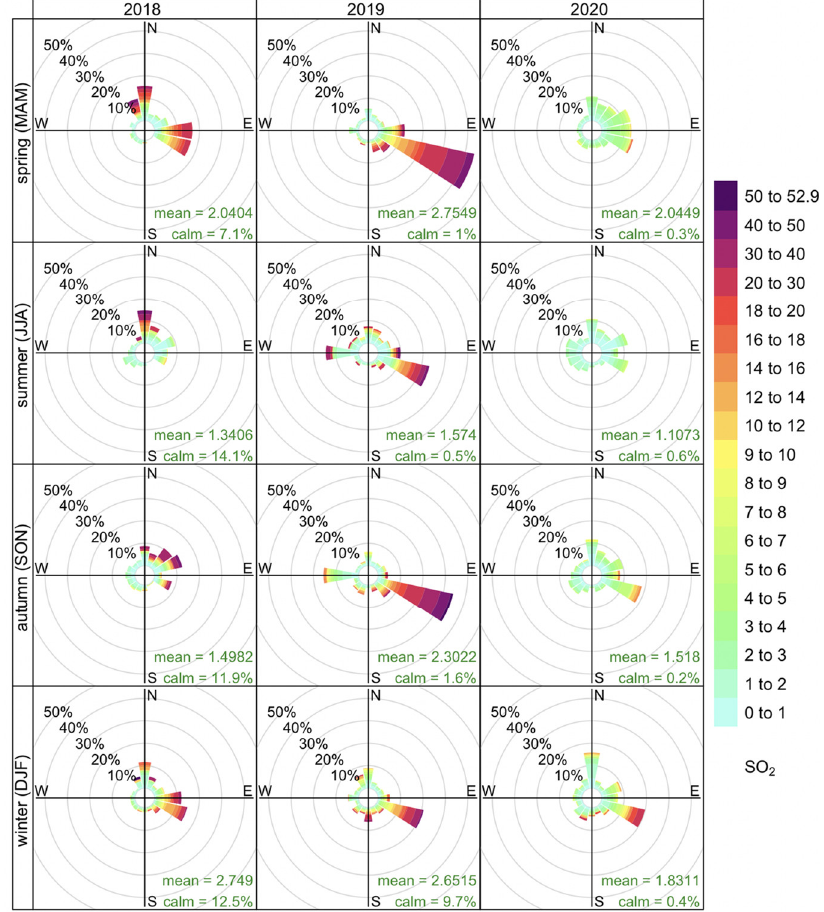
Figure 8. Prevalence of SO 2 concentration (µg/m 3 ) corresponding to AQMS.